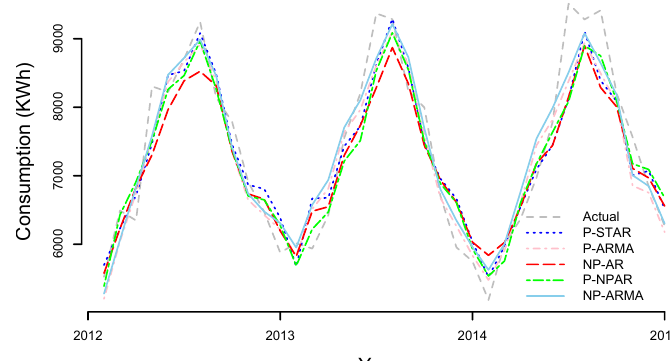
Figure 8. Actual and forecasted electricity consumption for only five best models (P-STAR. P-ARMA, NP-AR, P-NPAR, and NP-ARMA) for the period January 2011–December 2014